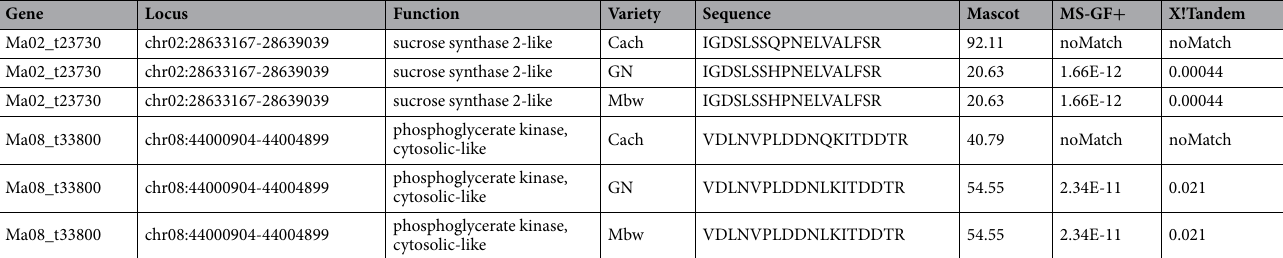
Table 1. Subset of the identified specific loci in 2 genes involved in glycolytic processes. The alternative cultivar specific sequences are provided. Identification scores from Mascot, msgf and x!Tandem search algorithms are given, noMatch: peptide not identified through this search algorithm.